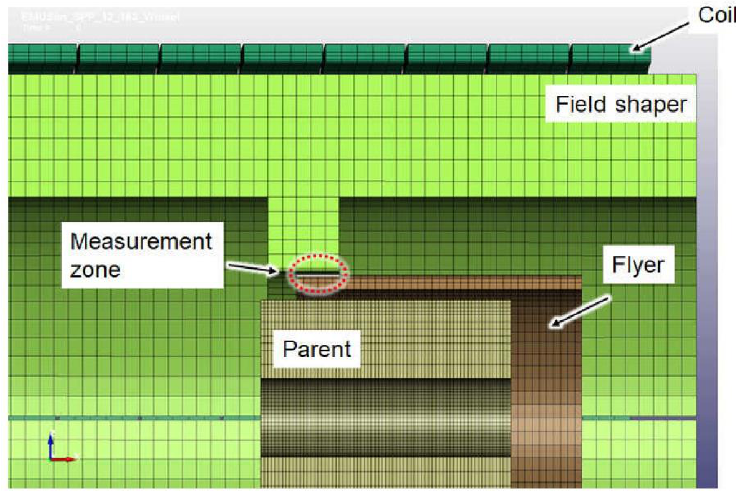
Figure 5. Setup in LS-DYNA simulation.